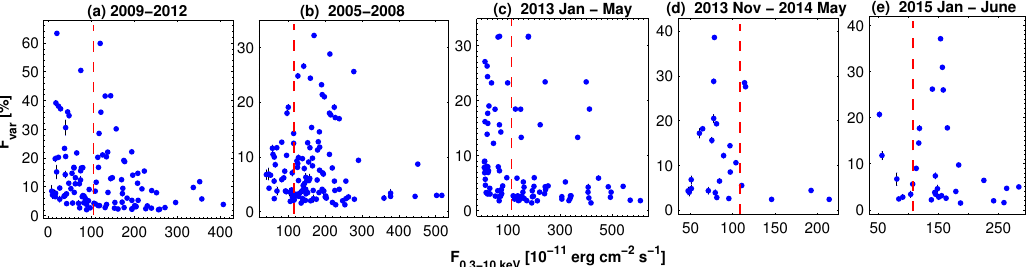
Figure 5. F var values from the 0.3–10 keV IDVs in Mrk421 plotted versus unabsorbed 0.3–10 keV flux in different periods. The vertical, red dashed line represents the mean weighted value of the 0.3–10 keV flux during 2005–2015 (reproduced from Kapanadze et al.